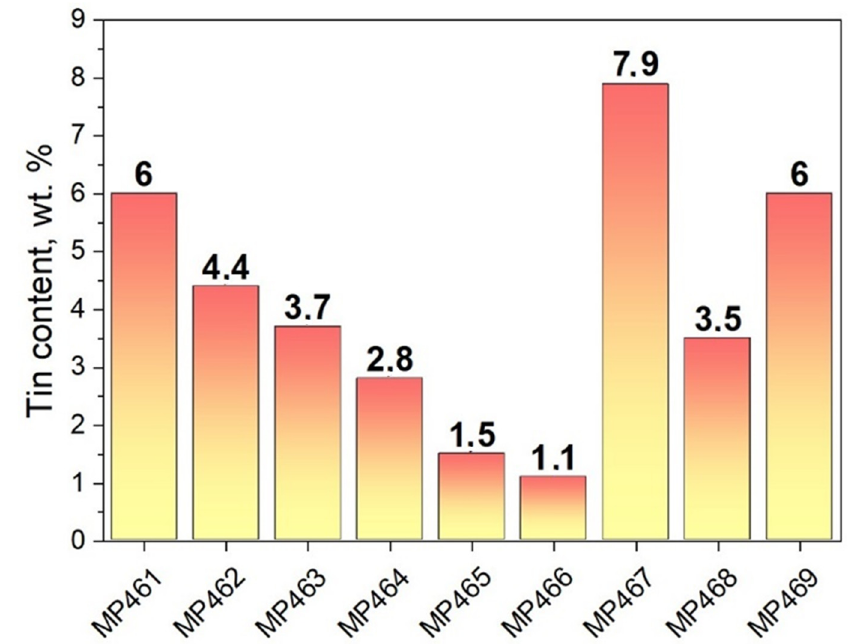
Figure 2. Diagram of the tin content in the studied bronze coins. The results were obtained from an analysis of neutron diffraction data. The average error in determining the tin content of bronze alloy does not exceed 0.3 wt.%.